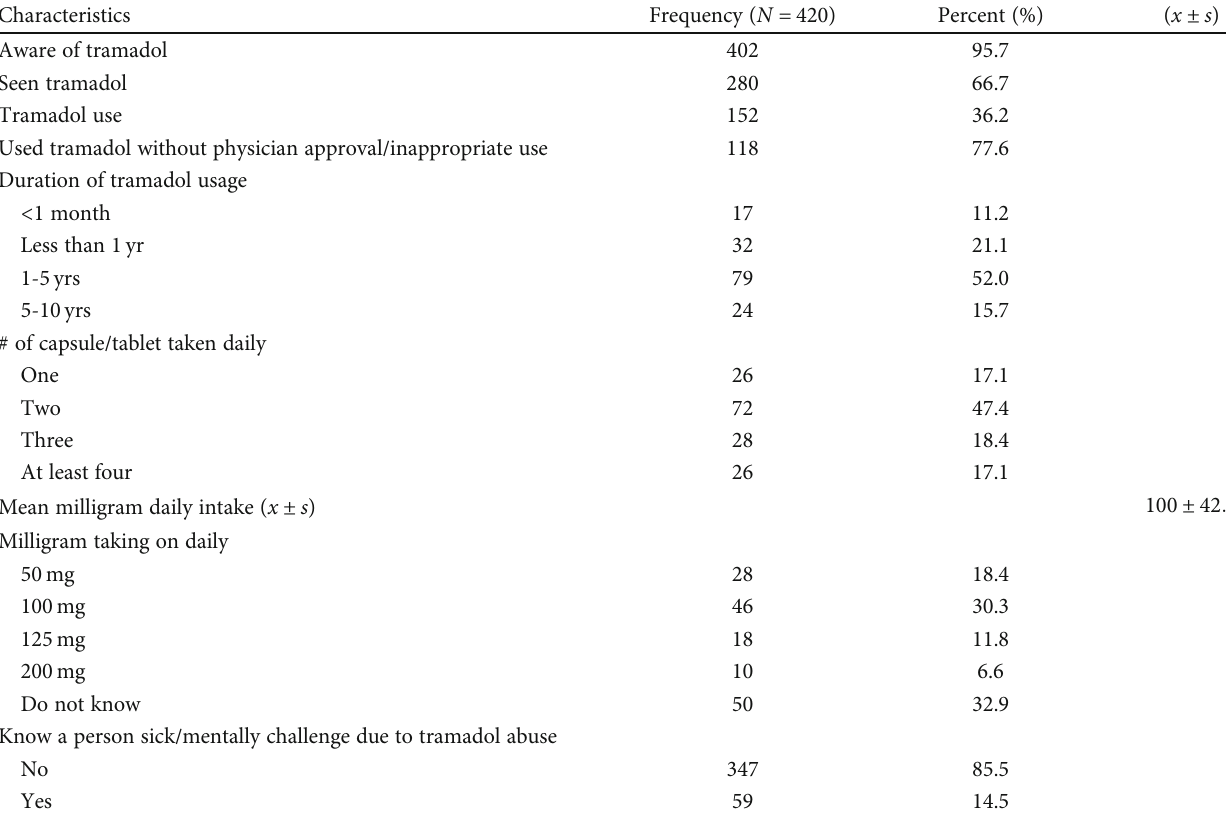
Table 2: Prevalence of tramadol